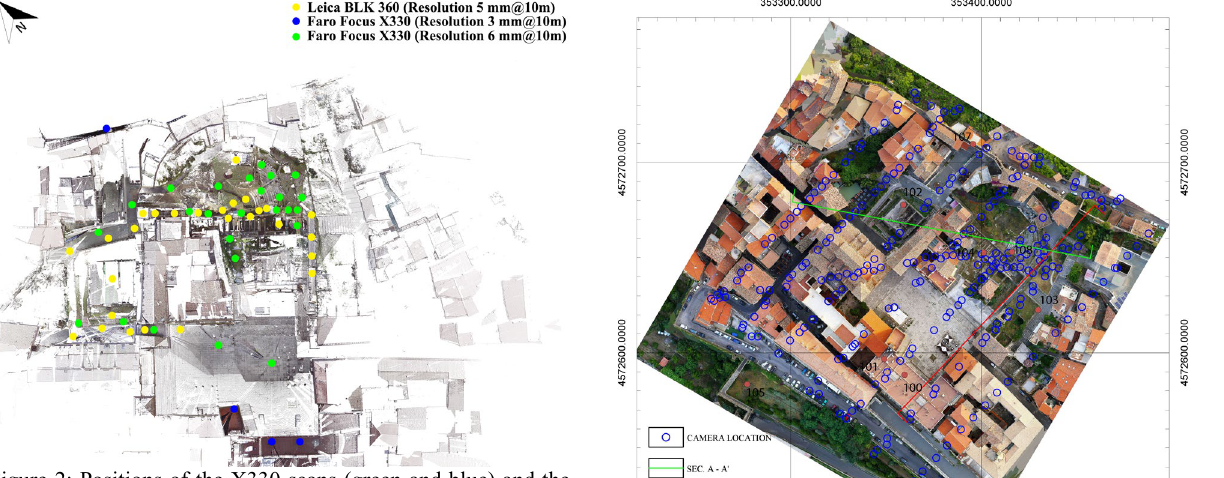
Figure 2: Positions of the X330 scans (green and blue) and the BLK360 scans (yellow)